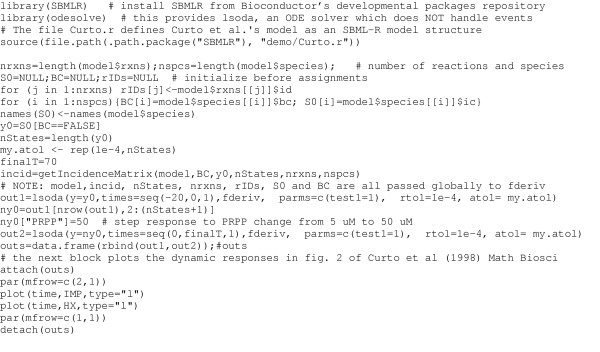
The purine metabolism model of Curto et al. represented in SBMLR Figure 1) simulated to respond to a 10-fold increase (5 μM to 50 μM) in phosphoribosylpyrophosphate (PRPP) at time t = 0